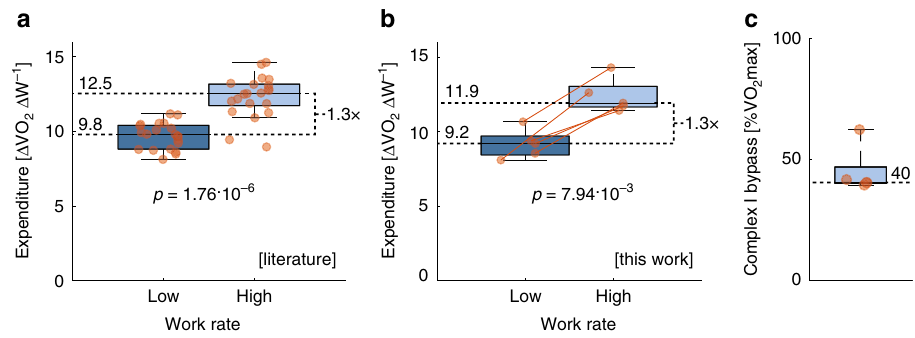
Fig. 3 Metabolic modes in subjects on exercise bike. a The oxygen expenditure, oxygen consumed (VO2) in ml per min per watt produced (W), is higher at high work rates for subjects ( N = 21) on an exercise bike, as calculated from published data 40 . b This was reproduced for the n = 5 subjects studied in this work. c The VO2 when the derivate increases for each subject was consistently calculate to ~40% of the maximum O 2 fl ux. Statistics were calculated using two-sided Mann – Whitney U test. The box plot indicates data between the 25th and 75th percentiles, the central mark indicates the median and whiskers extend to the most extreme data point within 1.5 × interquartile